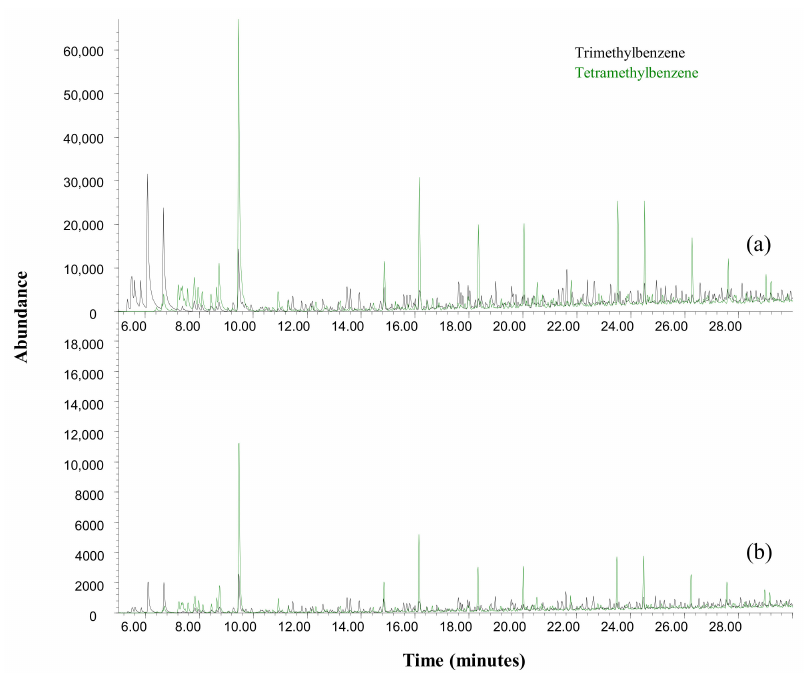
Figure 5. Chromatographic fingerprints of m / z 78 of ( a ) remaining oil after 120 h in the abiotic test and ( b ) remaining oil after 120 h of Y. lipolytica ’s growth in seawater with 1% v / v of oil.